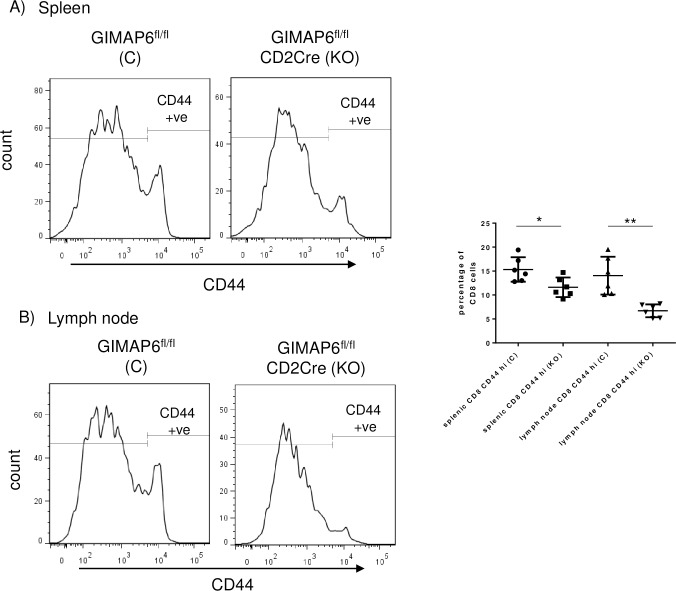
CD8+ cells from GIMAP6 fl/fl CD2Cre mice show a decrease in memory-like characteristics compared with GIMAP6 fl/fl mice.Total splenic or lymph node-derived cells were stained for CD8 and then with an antibody to CD44. The extent of staining of the CD8+ cells by CD44 for each group of cells is represented by histograms. For graphical analysis, CD44+ cells were gated as indicated from the histograms and plotted as a percentage of total CD8+ cells. n = 6. P values *p<0.05, **p<0.01.